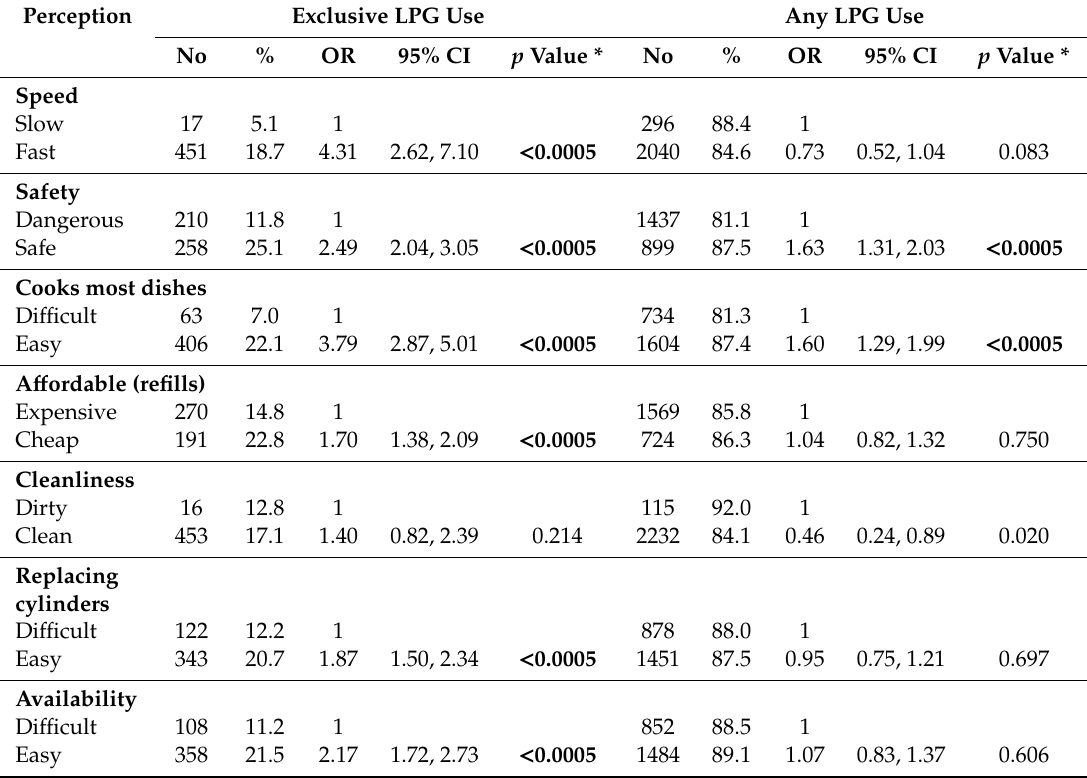
Figure 2. Perceptions of LPG according to whether it was used exclusively, in combination with another fuel or not at all. Table 7. Perceptions of LPG associated with extent of LPG use in peri-urban and rural households.